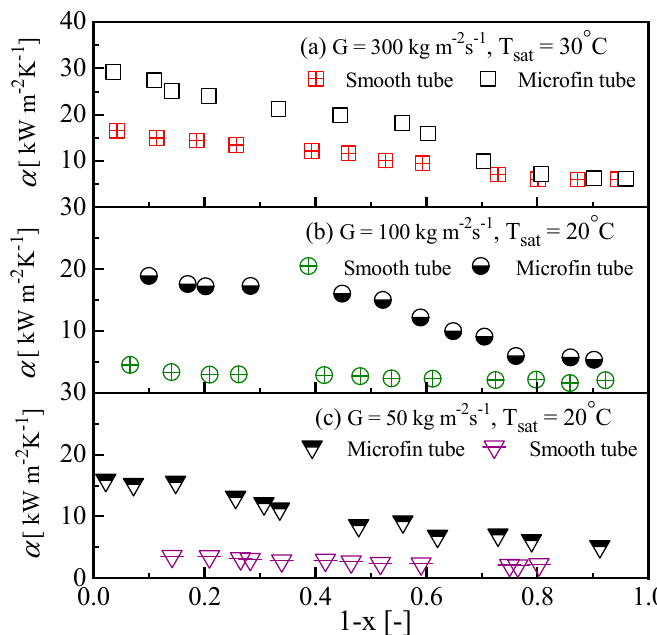
Figure 11. Effect of mass flux and vapor quality on condensation heat transfer coefficient at: ( a ) G = 300 kg m − 2 s − 1 ; ( b ) G = 100 kg m − 2 s − 1 ; and ( c ) G = 50 kg m − 2 s − 1 .